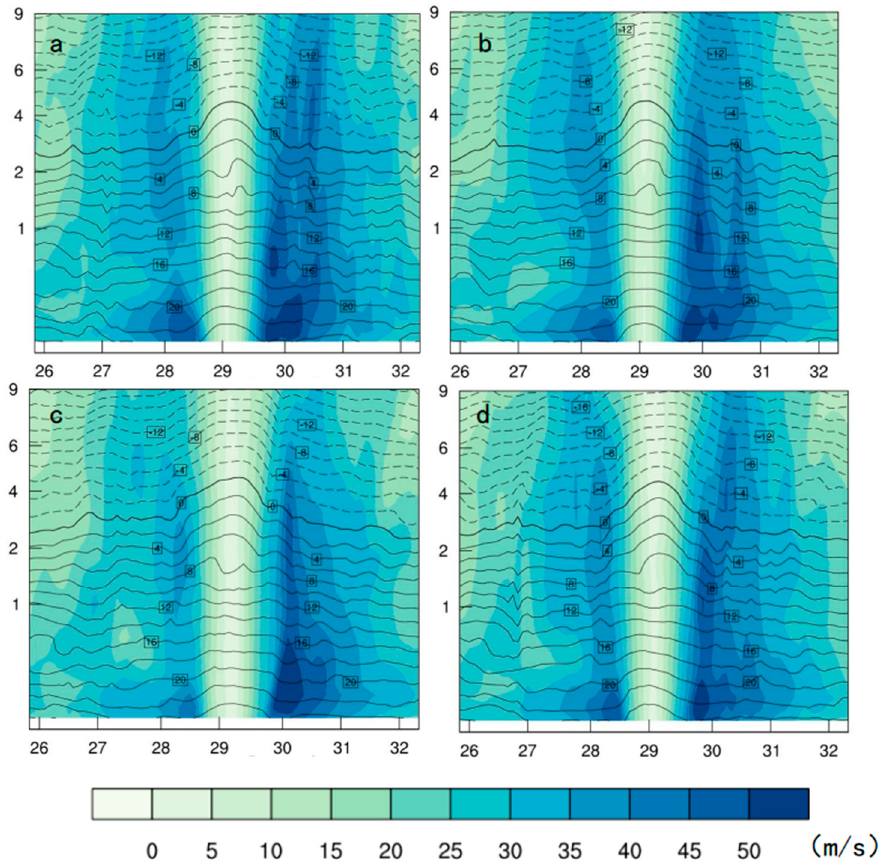
Figure 5. The north ‐ south cross ‐ sections of the horizontal wind speed and temperature through the vortex center at 0000 UTC 25 July 2021 ( a ) CTRL, ( b ) fy3_a, ( c ) fy3_d, and ( d ) fy3_m (the shaded is the horizontal wind speed, unit: m ∙ s − 1 ; the black solid line is the temperature, unit: °C).